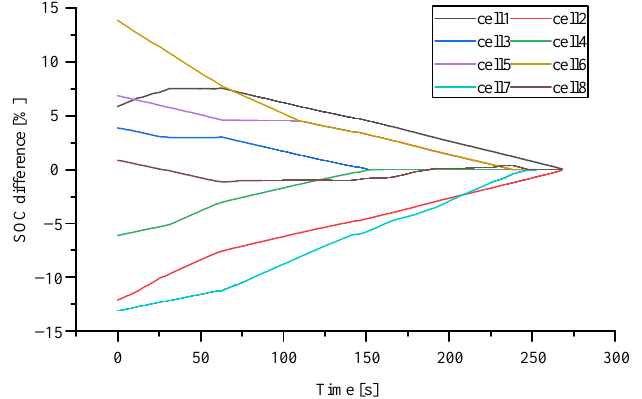
Figure 9. ( a – h ) lithium battery current change diagram, the blue dotted line represents the normal operating current range. (Multi-layer equalisation circuits and equalisation strategies in this paper).